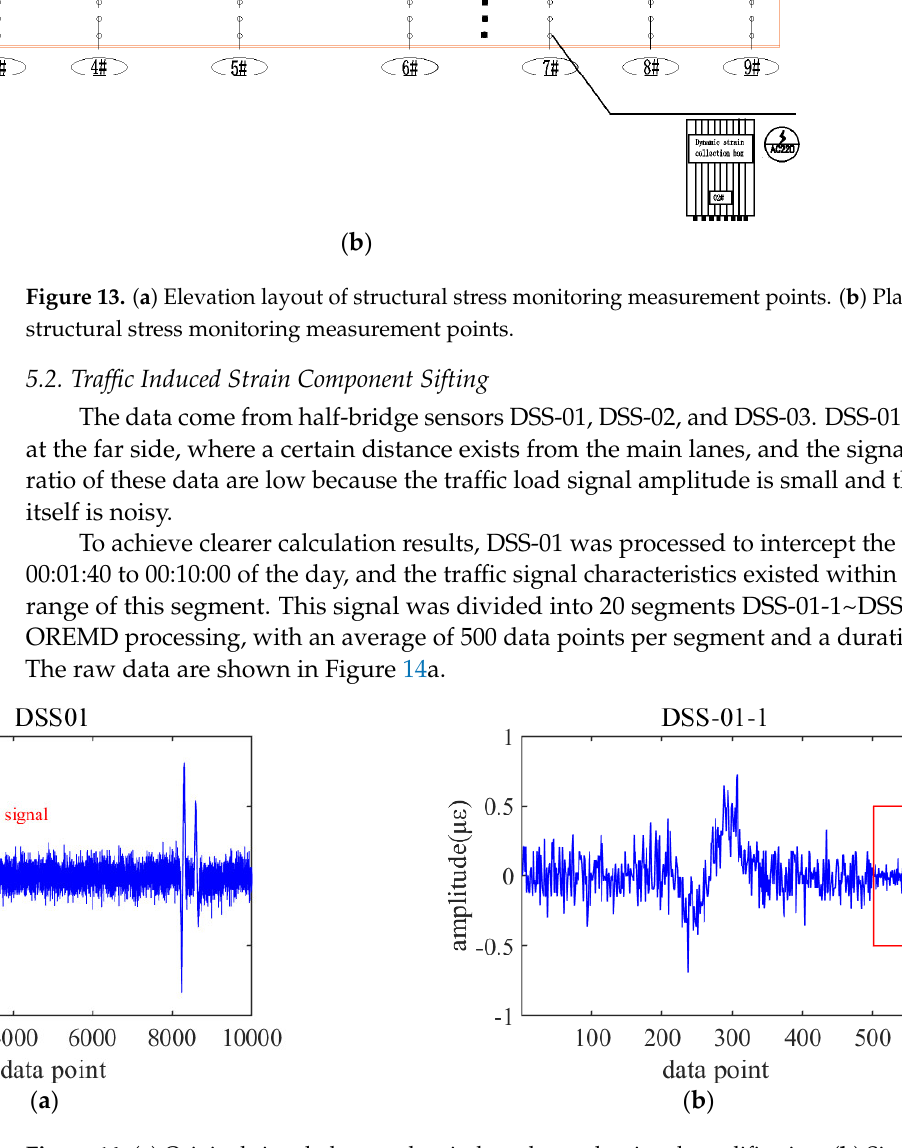
Figure 14. ( a ) Original signal; the purple window shows the signal amplification. ( b ) Signal ampli- fication area; the red window shows the extension result.